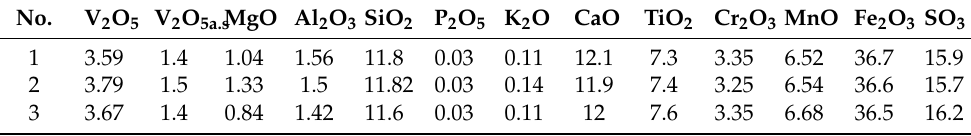
Table 1. Chemical composition of vanadium-containing sludge samples, %wt.